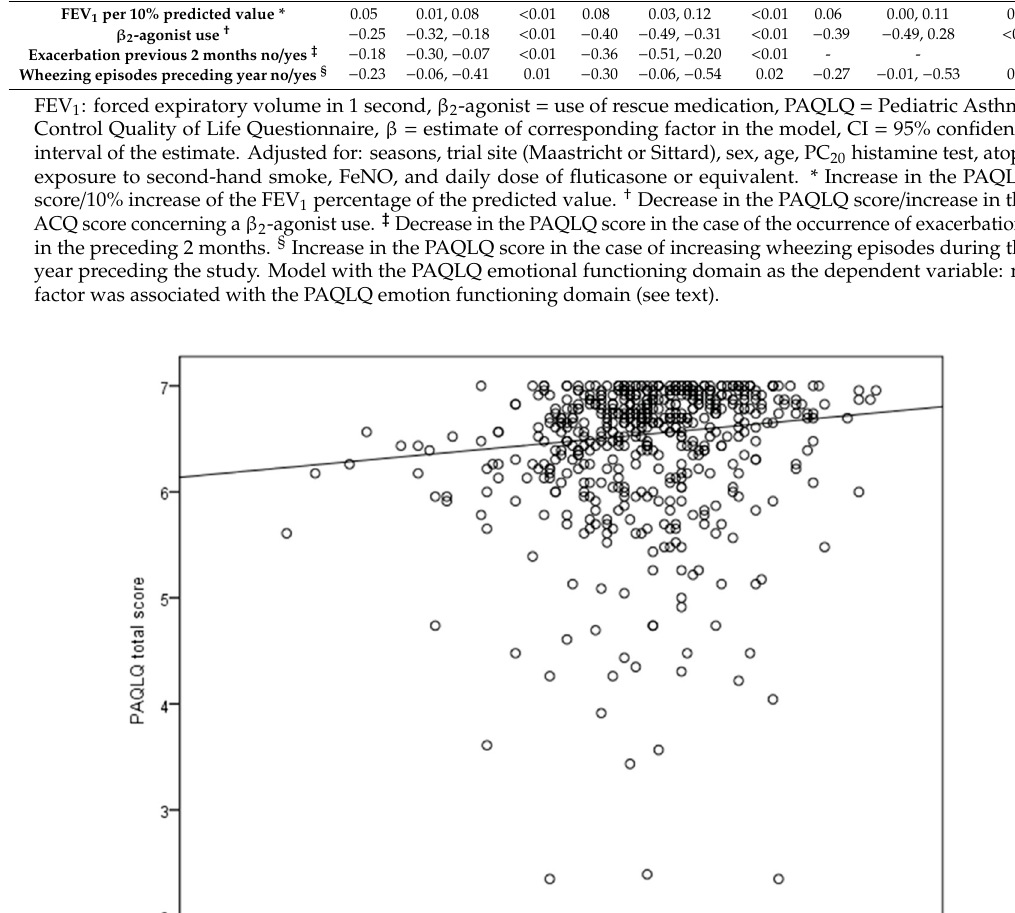
Figure 4. Associations between lung function and the PAQLQ total score in a linear mixed model—all measurements taken during one year were included. The regression line is based on the model in which the asthma control levels were excluded, the estimates of this model are given in Table 5. For factors in the equation other than the FEV 1 percentage of the predicted value, mean values were used.